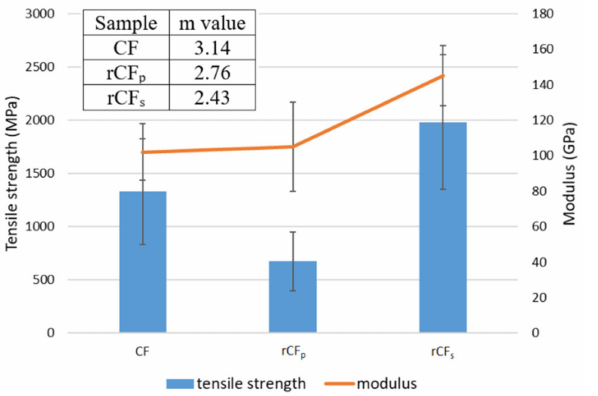
Figure 2. Tensile strength and modulus of CF, rCF p , and rCF s and the corresponding shape parameter m. Interestingly, the moduli of all three sample types were quite similar, with rCF s showing only slightly (~40 GPa) higher values. Additionally, fiber diameter (6.4 µ m) remained the same for both the rCF p and rCF s , despite the large difference in the